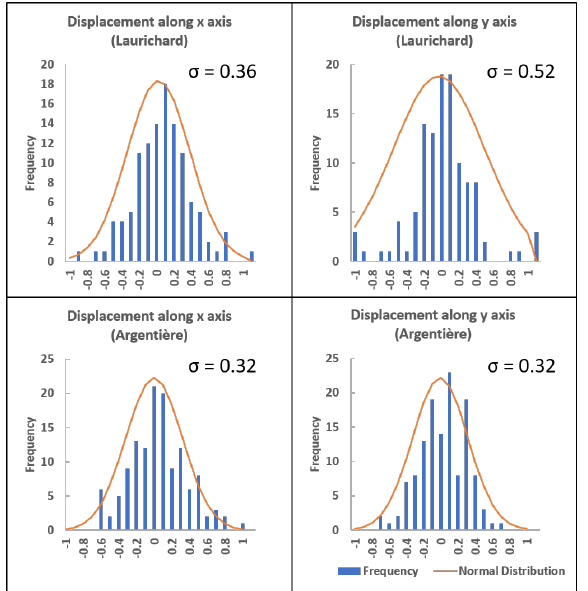
Figure 5. Histogram of displacement over fixed area computed on 114 (Laurichard) and 132 (Argentiere) images with reference images.